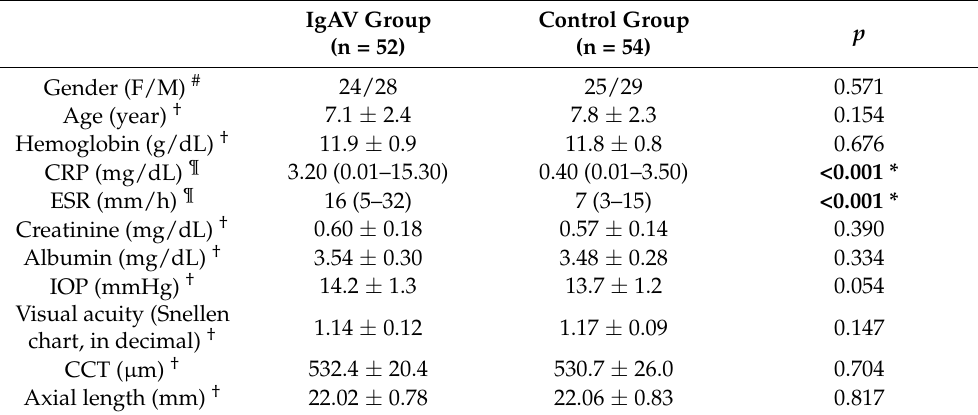
Table 1. Demographic, laboratory, and ocular characteristics of the